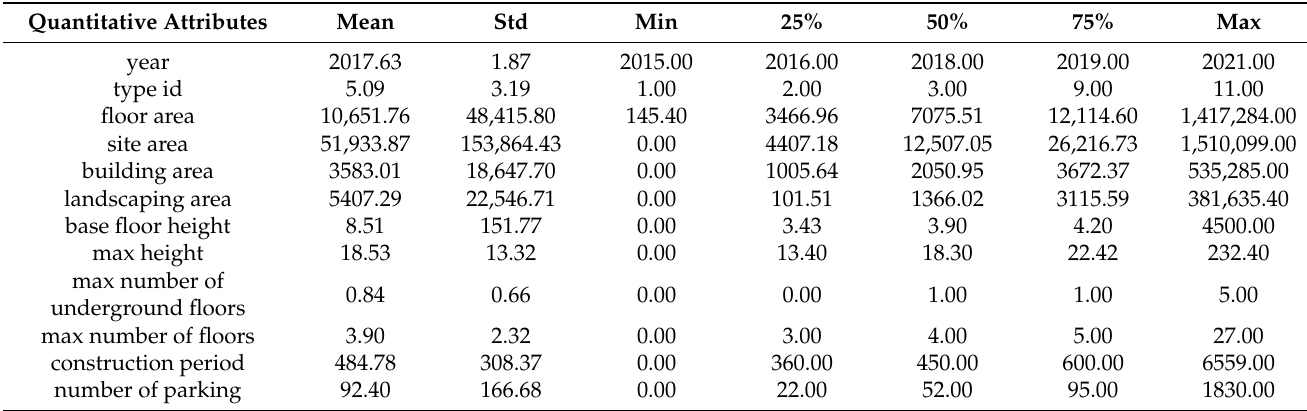
Table 3. Statistical description of quantitative